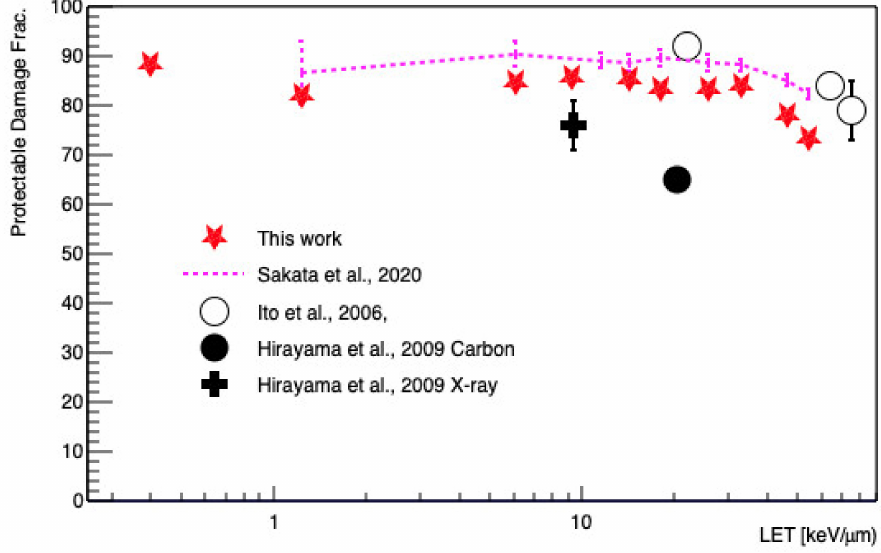
Figure 6. Protectable damage fraction, which is the ratio of protectable DSBs over the total number of DSBs, as a function of LET. Geant4-DNA simulations and measurements are